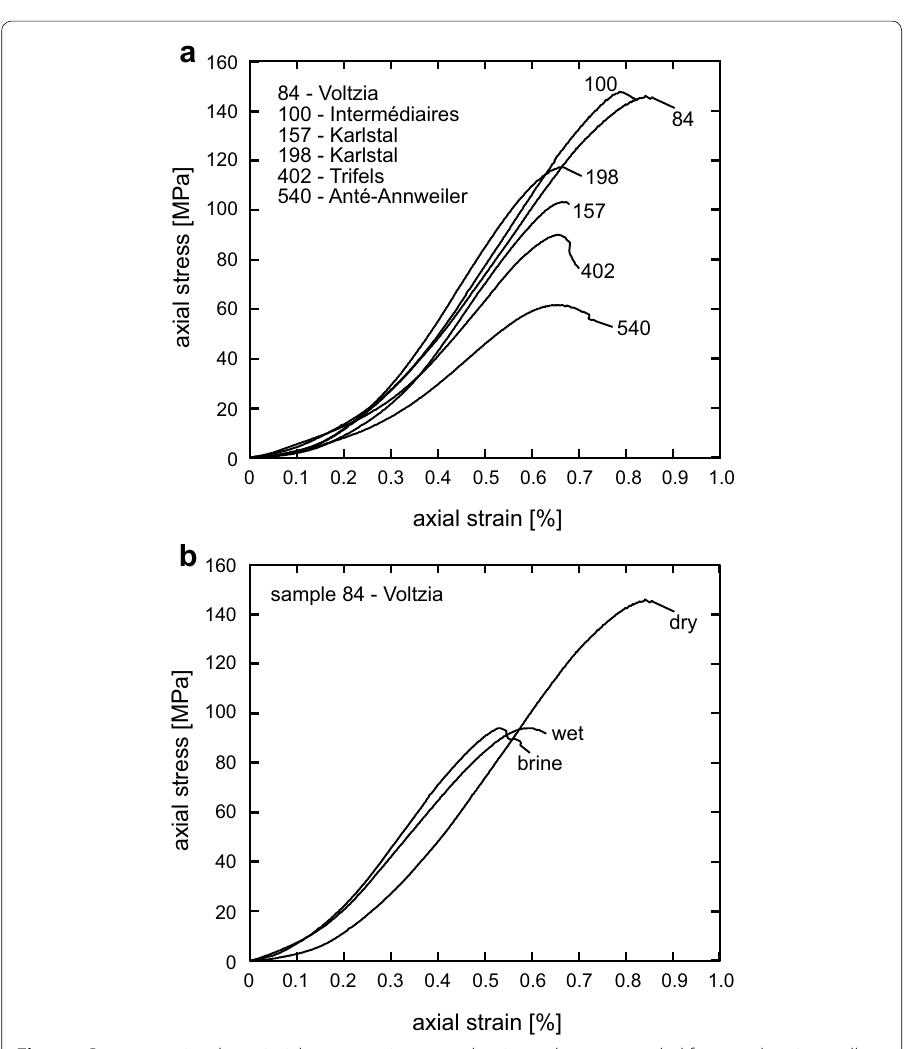
Fig. 5 a Representative dry uniaxial stress–strain curves the six sandstones sampled from exploration well EPS-1 at Soultz-sous-Forêts (France). The number next to each curve indicates the core box number. b Representative dry, water-saturated, and brine-saturated uniaxial stress–strain curves for samples taken from core box number